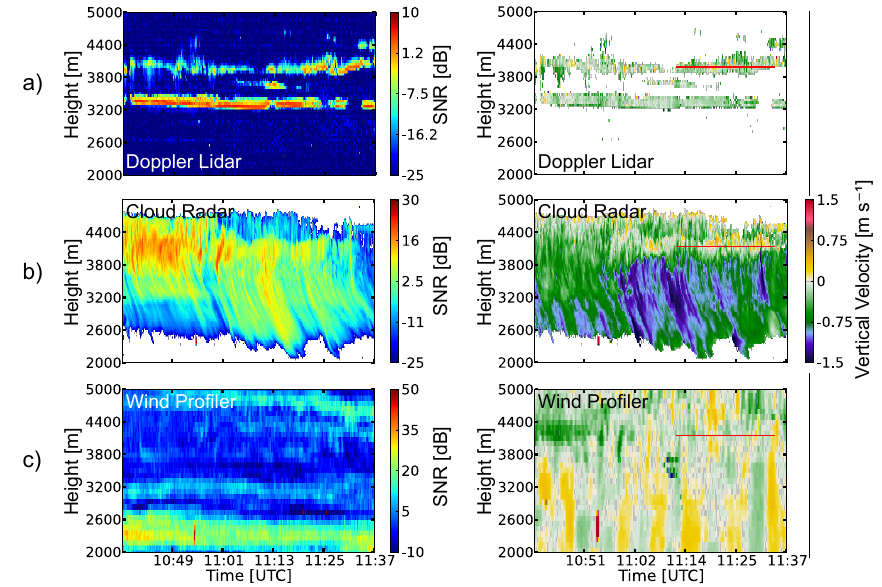
Figure 8. An example of vertical velocities measured in mixed-phase cloud layer recorded on 25 September 2013 at MOL. It is clearly visible that the information of Doppler lidar, cloud radar and wind profiler are mostly disjunct and represent turbulent motion in liquid layers (Doppler lidar), falling particles (Doppler lidar and cloud radar) and vertical air motion (wind profiler). The red line represents the vertical velocity values from which the turbulence spectra in Fig. 9 were computed. Radiosonde shows a cloud-top temperature of − 13 ◦ C. 0 ◦ C is reached at 2000m